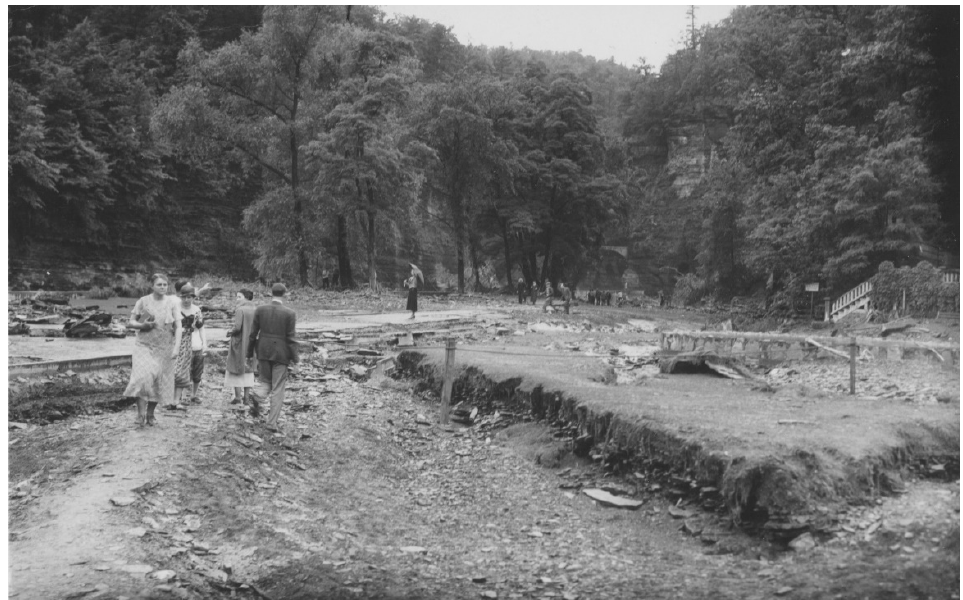
Figure 13. Entrance Lawn after the flood, July 1935. Photo used with permission: NY State Office of Parks, Recreation & Historic Preservation; parks.ny.gov (accessed on 12 June 2019).